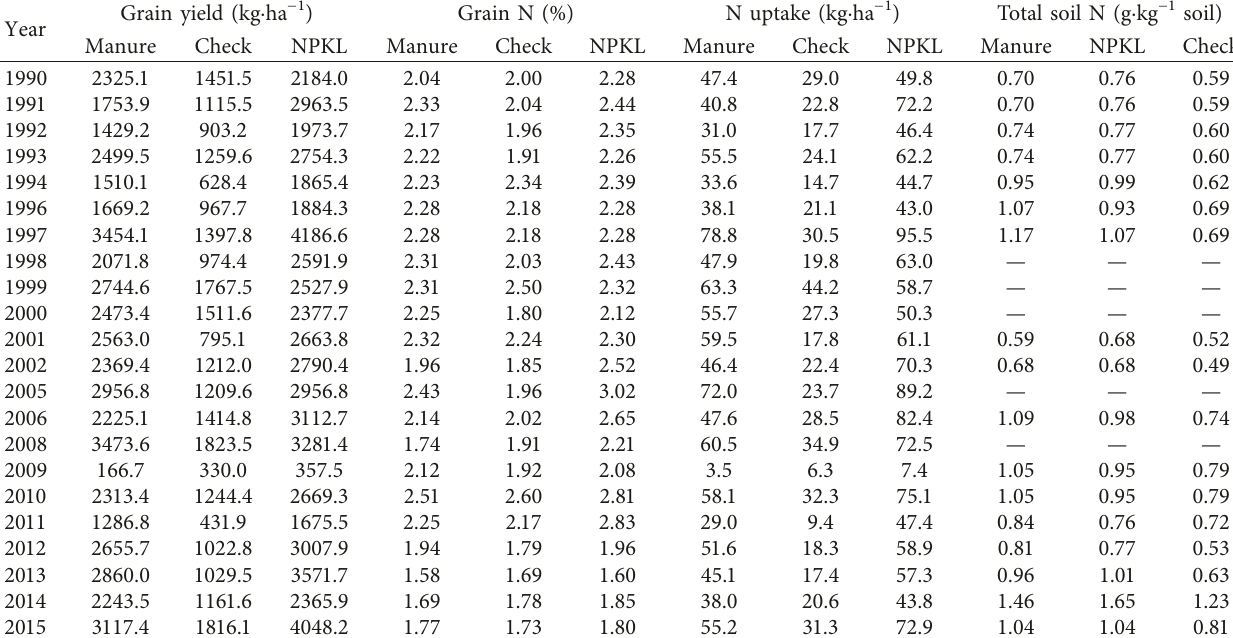
Table 2: Wheat grain yield (kg · ha − 1 ), grain N content (%), N uptake (kg · ha − 1 ), and total soil N (g · kg − 1 soil) of Magruder Plots (1990–2015) located at Stillwater in Oklahoma,